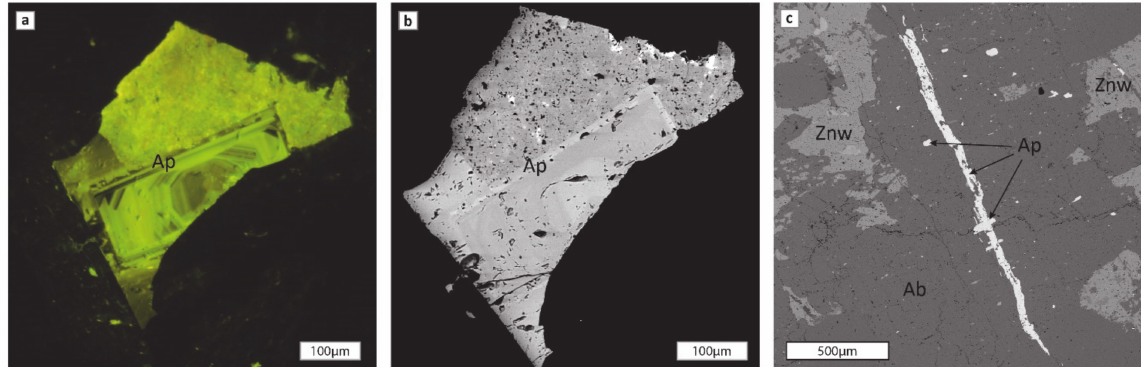
Figure 5. ( a ) Image of apatite in cathodoluminescence, ( b ) SEM (back-scatter electrons imaging (BSE)) image of zoned apatite, and ( c ) SEM (BSE) image of vein secondary filled by apatite. Explanation: Ap = apatite, Znw = zinnwaldite, Ab = albite.